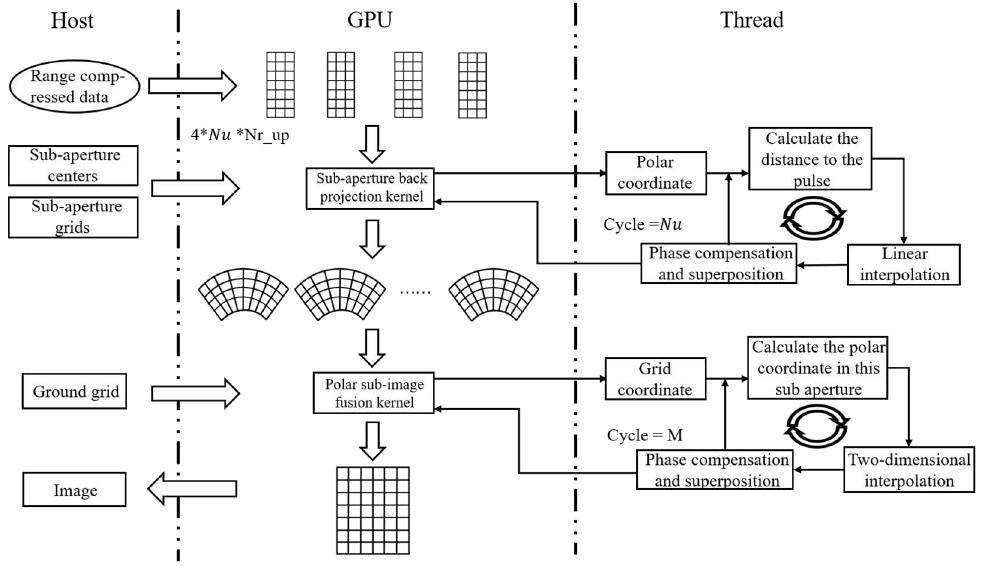
Figure 4. Parallel FBP